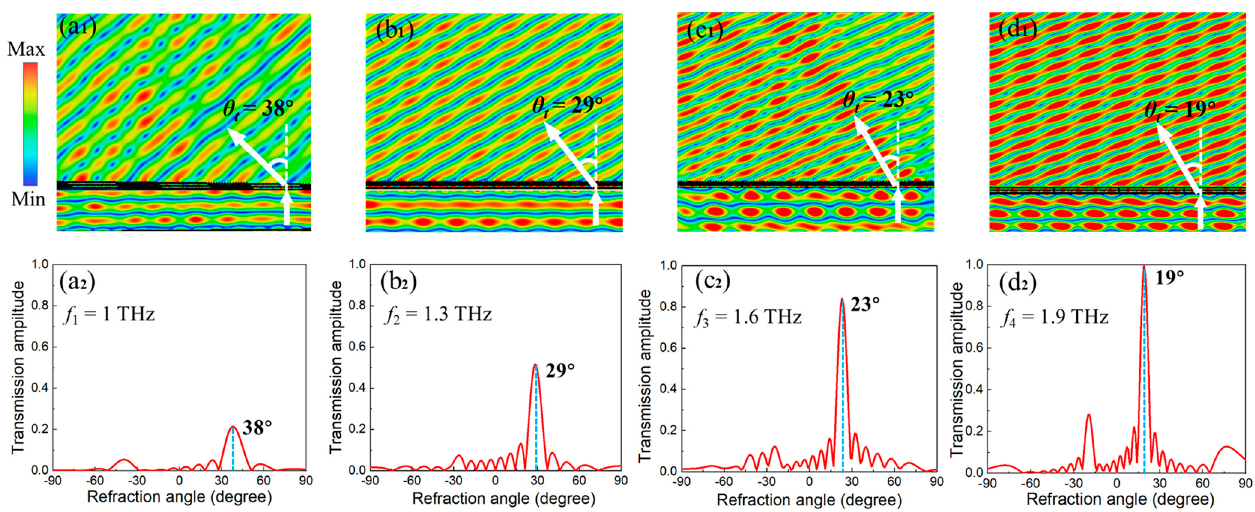
Figure 5. ( a 1 – d 1 ) The electrical field in x - z plane. ( a 2 – d 2 ) The normalized far-field power intensity in x - z cutting plane at four typical frequencies, respectively.